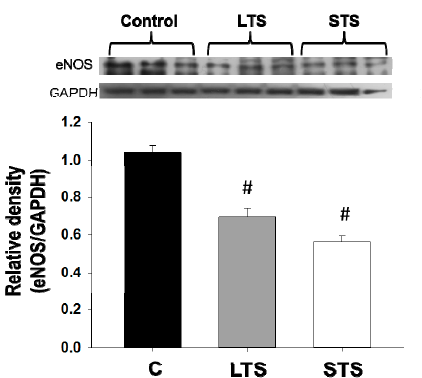
Figure 3. The effects of long-term (LTS) and short-term (STS) administration of sucrose on protein expression of eNOS. Data represent mean ± SEM, # p < 0.05 after one-way ANOVA, n = 8 lanes in Western blots in which homogenates of aortas from 8 different rats from each group were run. A representative Western blot analysis is shown above the graph.